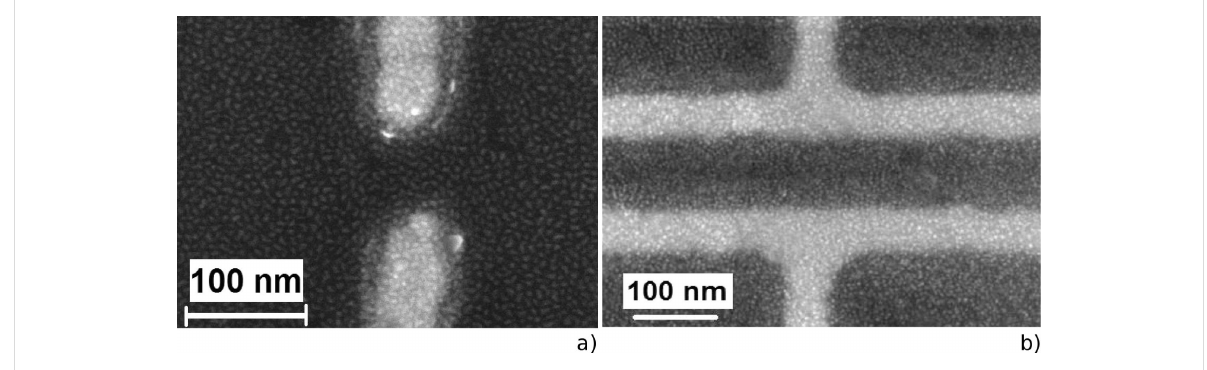
Figure 7: SEM images of the nanoantenna edges for a) linear and b) H-shaped nanoantennas taken after deposition of 1 ML of CdSe NCs. Figure 7a is reprinted with permission from [23], copyright 2017 American Chemical Society.